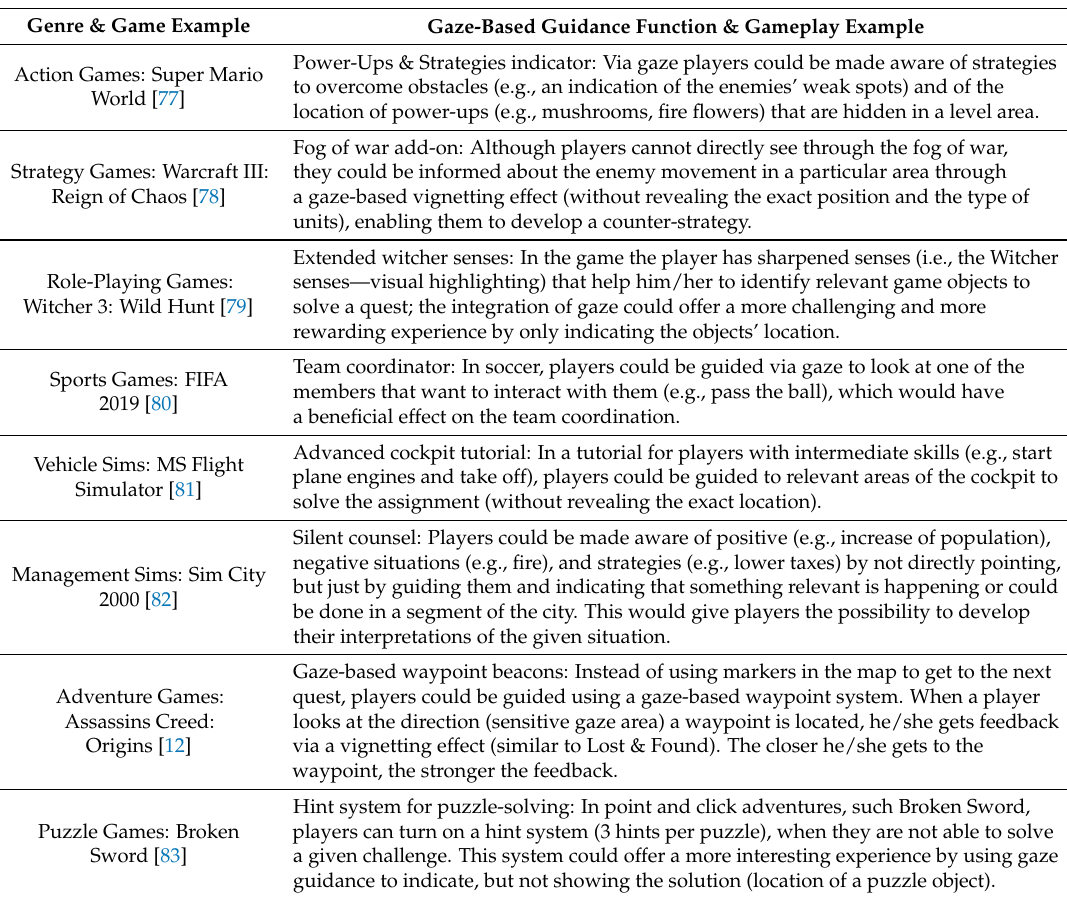
Table 2. An overview of potential use cases of gaze-based guidance in the context of games. Genre & Game Example Gaze-Based Guidance Function & Gameplay